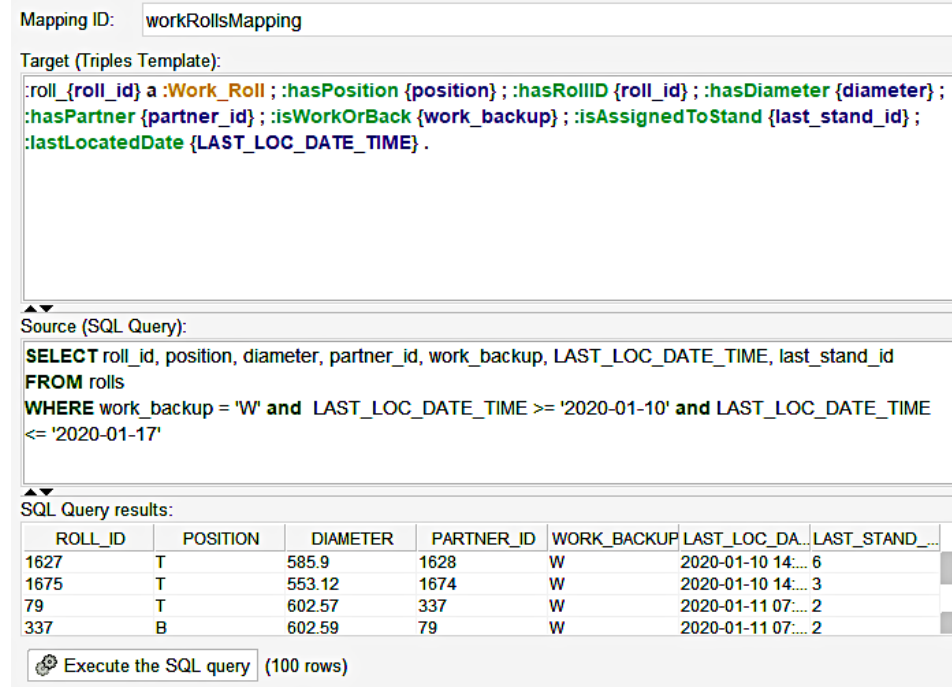
Figure 5. Ontop mapping for work